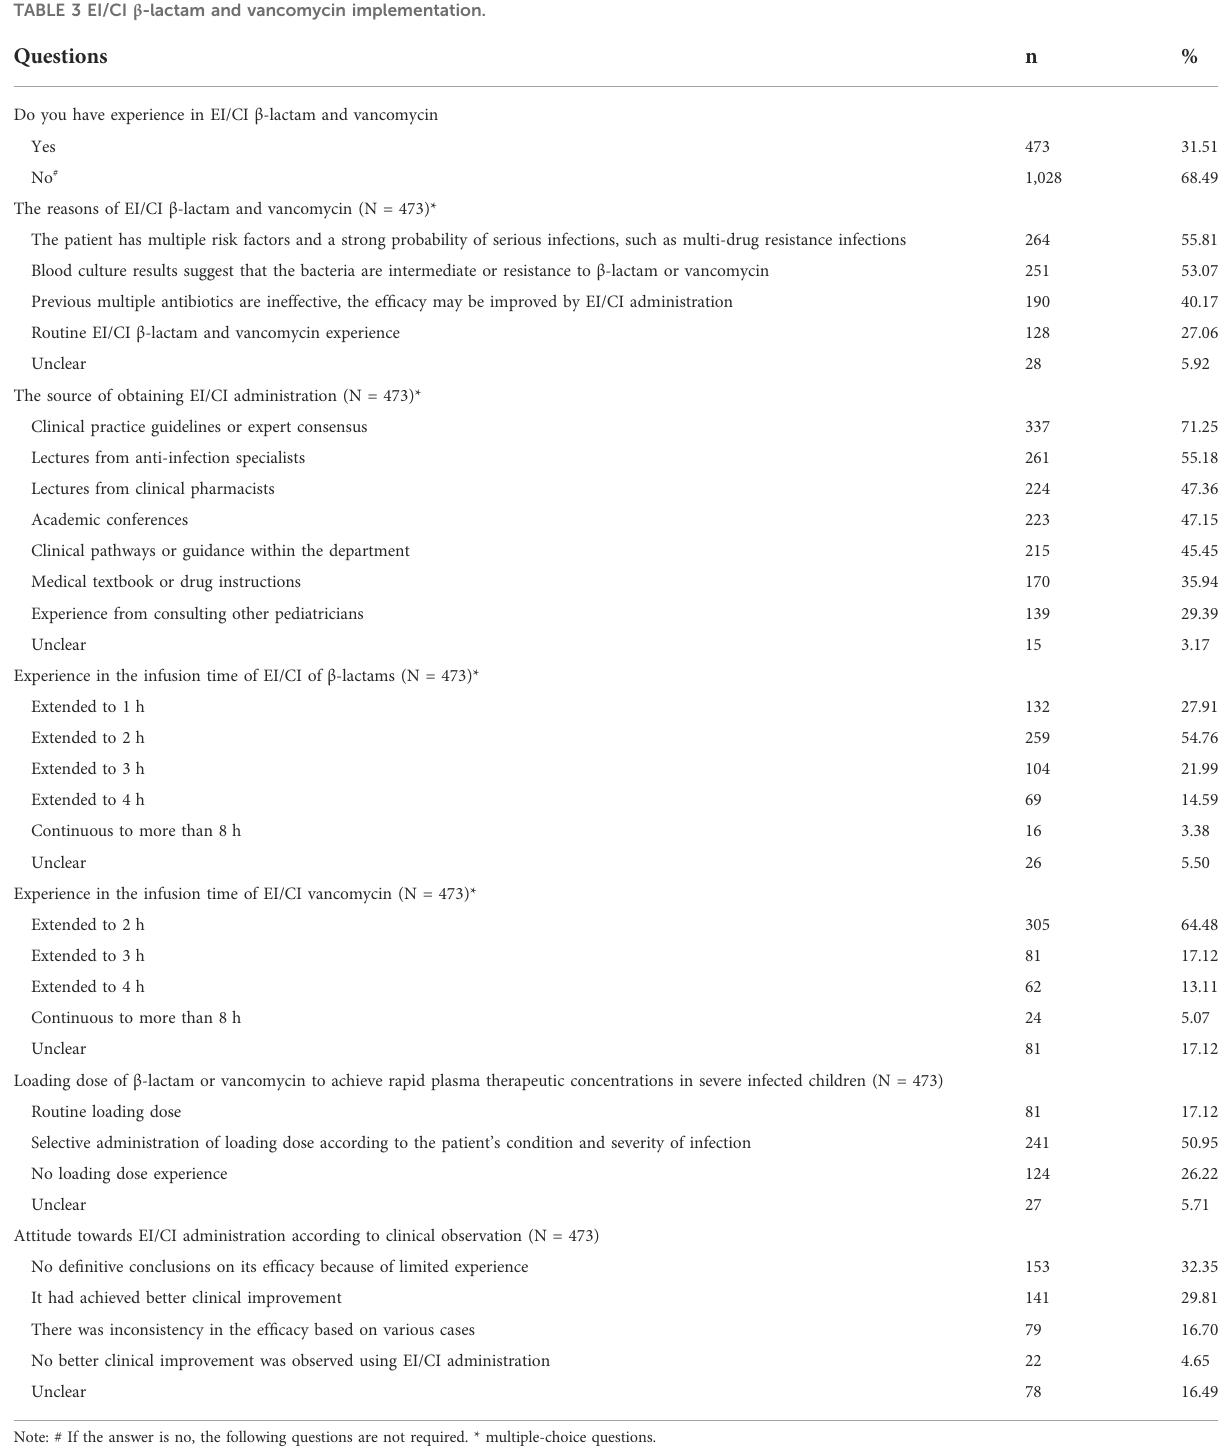
TABLE 3 EI/CI β -lactam and vancomycin